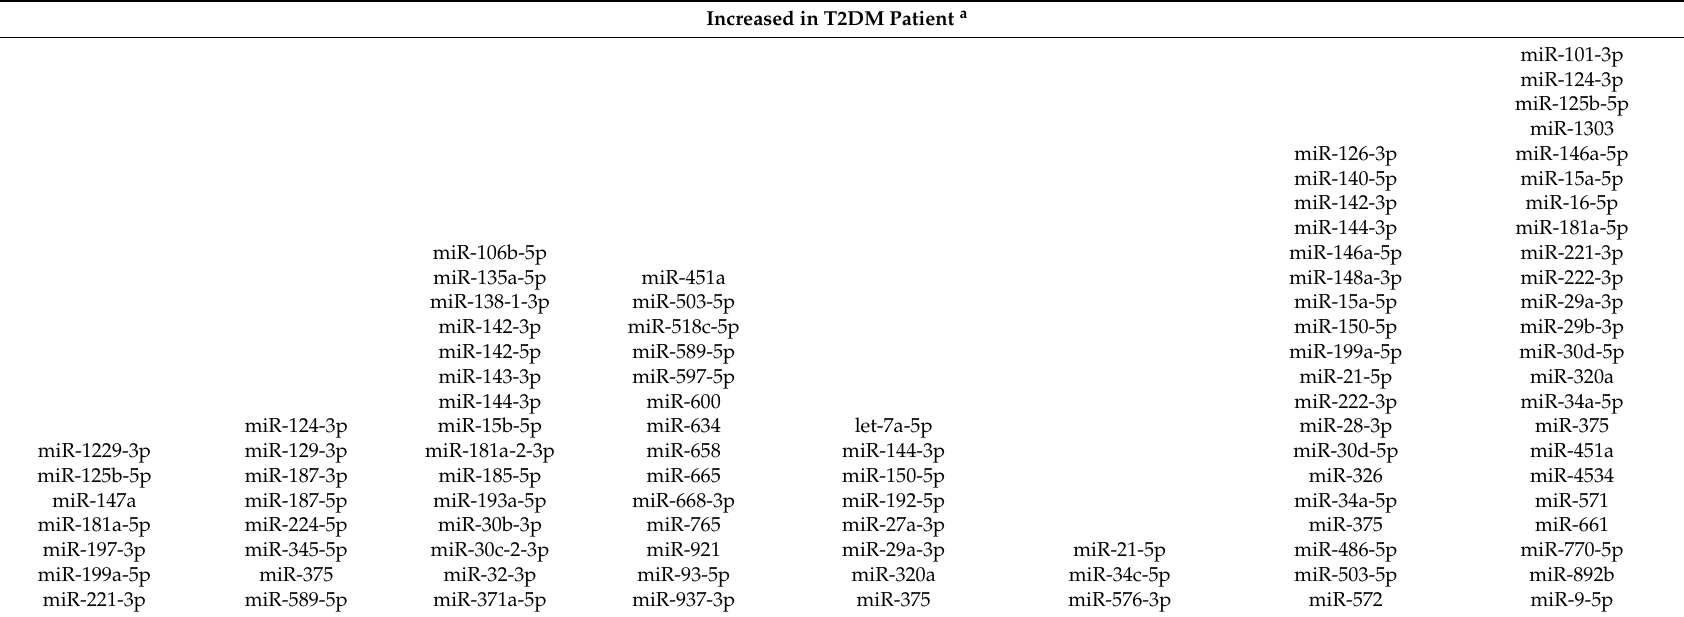
Table 2. List of dysregulated miRNAs identified from seven different types of samples used in T2DM